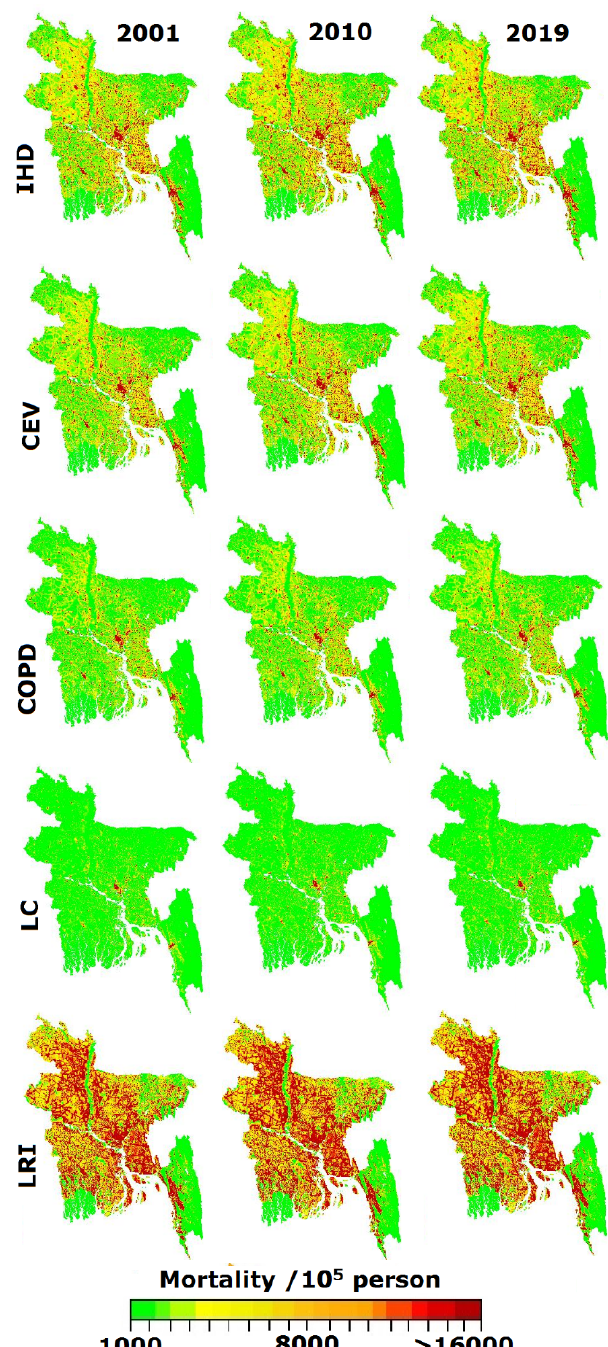
Figure 9 . Spatial distribution of excess mortality associated with PM 2.5 for three representative